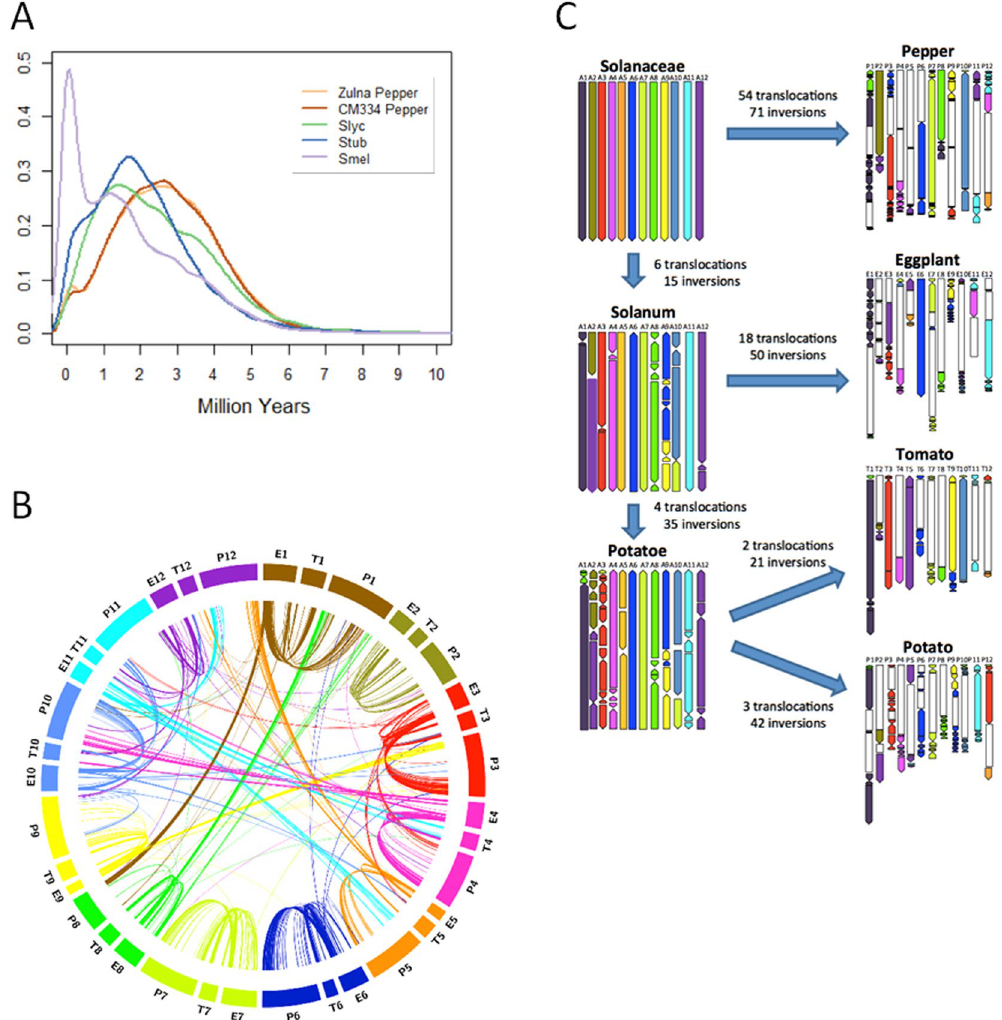
Figure 2. Solanaceae genome dynamics. ( A ) Dating of insertions for complete LTR retrotransposons in the various Solanaceae genomes. ( B ) Syntenic relationships between the chromosomes eggplant (E), tomato (T) and pepper (P). For the parameters used to define synthenic thresholds, see Supplementary Information 2.7. ( C ) Reconstruction of chromosome dynamics during Solanaceae evolution. Each chromosome of the hypothetical Solanaceae common ancestor is assigned a different colour. The reconstructed karyotypes of evolutionary intermediates are shown on the left, the actual karyotypes of extant species on the right. Chromosomal segments derived from each ancestral chromosome are painted with the corresponding colour, and the arrows indicate the orientation with respect to the ancestral chromosome segment. The minimum number of translocations and inversions occurring between two karyotypes are